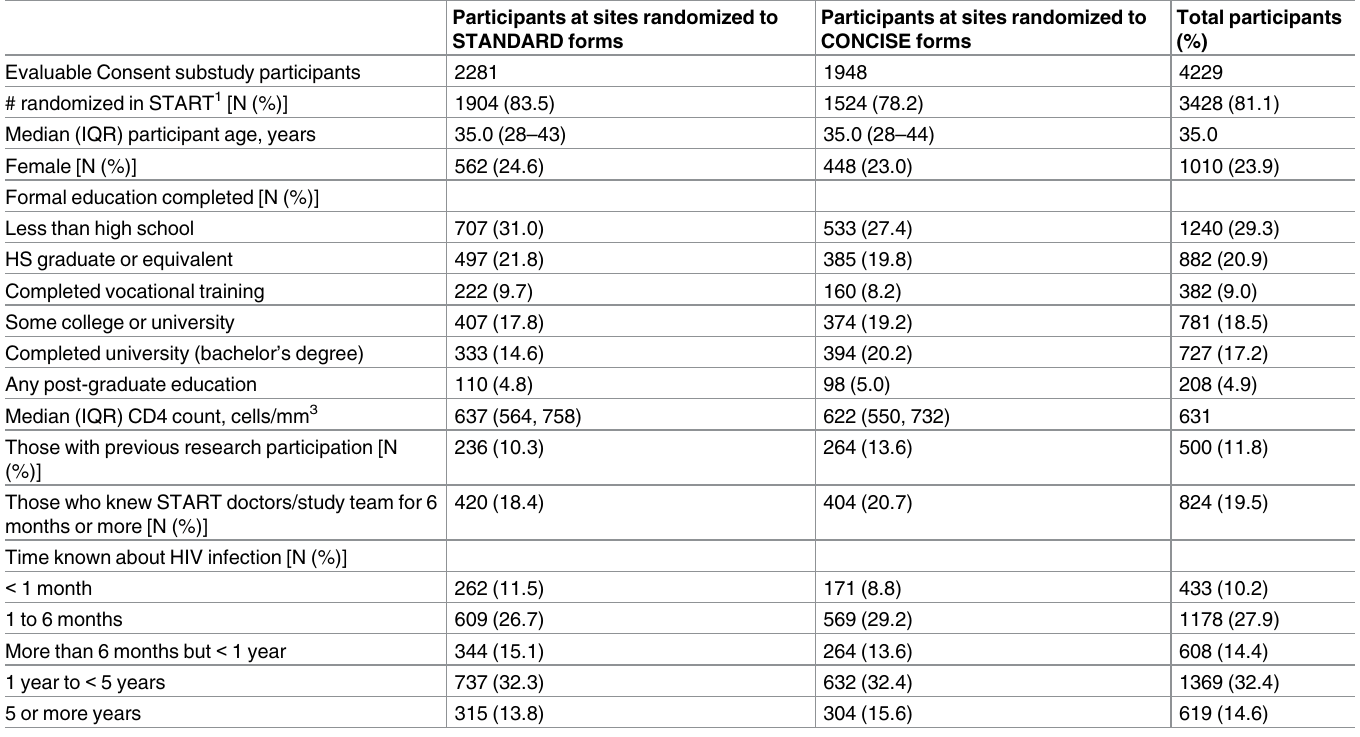
Table 2. Characteristics of informed consent substudy participants by consent group.